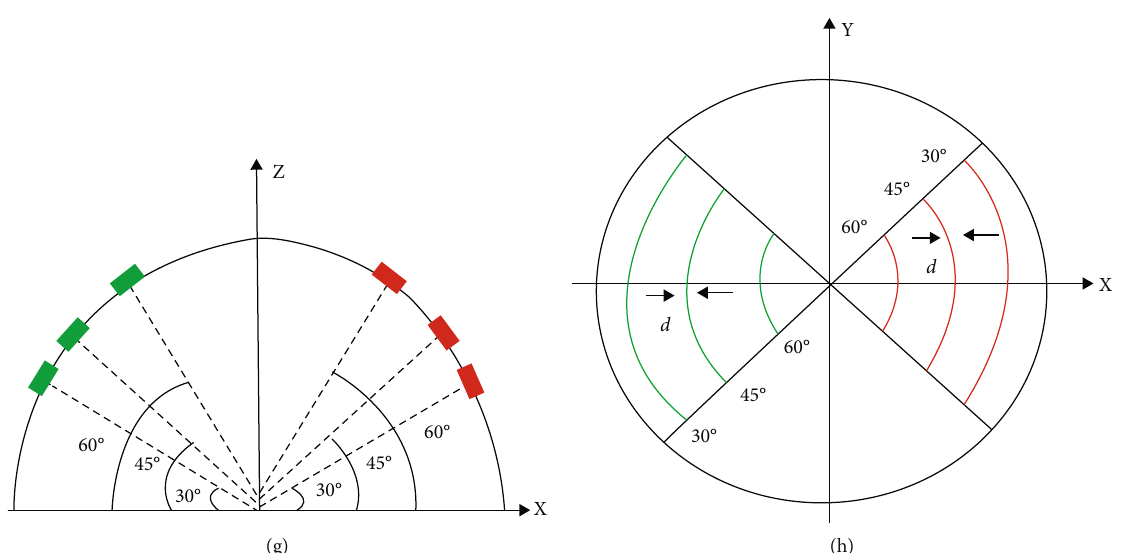
Figure 2: Analytical method of wall FSS on cell surface. (a) Mesh dependency analysis. (b) FE mesh and wall FSS of gradient fl ow chamber. (c) Numerical simulation results of wall FSS on the bottom plate at the location indicated by the red box in (b). (d) Wall FSS of all nodes at di ff erent FSS gradients and linearly fi tted by the dotted line. (e) Fluid velocity of the locations with the same height of 0.4mm and two di ff erent x positions. (f) Dorsal surface of a cell divided into four sectors, including the sectors with higher global FSS (SHFSS) and lower global FSS (SLFSS). (g) Bands on the cell surface with three orientations, i.e., 30 ° , 45 ° , and 60 ° . (h) Top views of the bands with di ff erent orientations in the